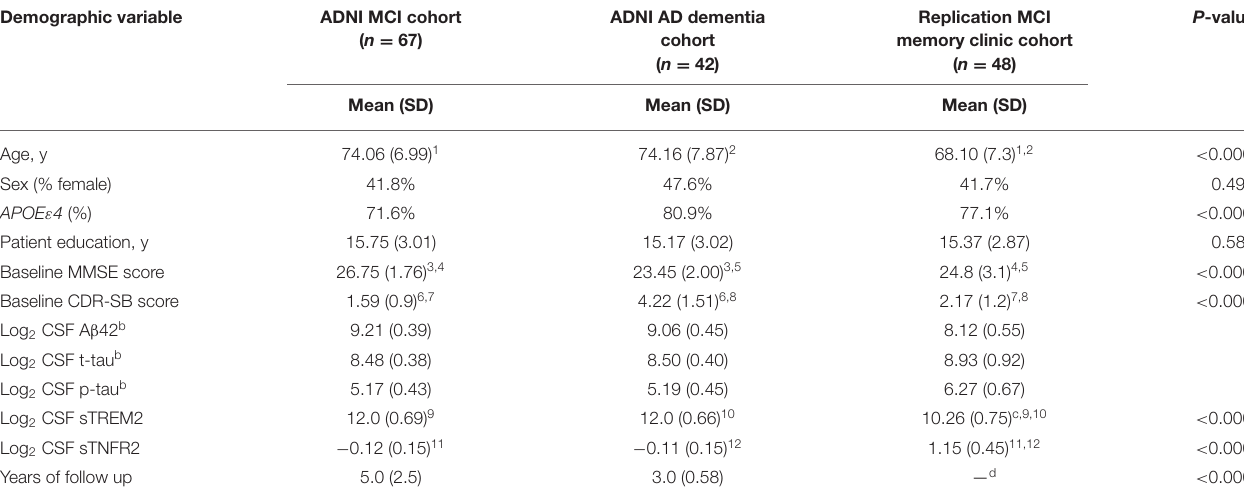
TABLE 1 | Demographics of participants from the Alzheimer’s Disease Neuroimaging Initiative (ADNI) and replication memory clinic cohorts (participants meeting A + T + criteria and concomitant sTREM2 and sTNFR2 data). Demographic